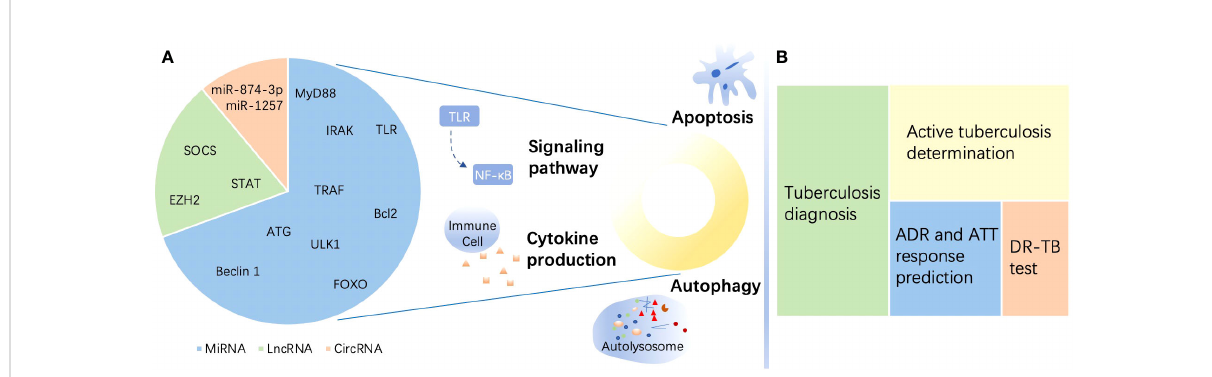
FIGURE 1 A brief summary of the roles of noncoding RNAs in tuberculosis. (A) Targets of noncoding RNAs (ncRNAs) in immune regulation in tuberculosis (TB) and estimated proportion of studies directed to the three ncRNAs enumerated in this review. MicroRNAs (miRNAs) mostly target myeloid differentiation factor 88 (MyD88), Toll-like receptor (TLR), tumor necrosis factor (TNF) receptor-associated factor (TRAF), and interleukin-1R- associated kinase (IRAK) to regulate signaling pathways and target Unc-51-like autophagy-activating kinase 1 (ULK1), autophagy-related gene (ATG), and beclin 1 to affect autophagy. Moreover, miRNAs target the Bcl-2 family and Forkhead box transcription factor class O (FOXO) to modulate apoptosis during TB. Long noncoding RNAs (lncRNAs) regulate the immune response in the host by targeting enhancer of zeste homolog (EZH) 2, suppressor of cytokine signaling (SOCS), signal transducer and activator of transcription (STAT), etc. Circular RNAs (circRNAs) perform immunity functions by acting as miRNA sponges. (B) ncRNAs serve as biomarkers in TB. ncRNAs show the potential to be biomarkers of different functions including diagnosis, active individual determination, adverse drug reaction (ADR) and response to antituberculosis therapy (ATT) monitoring, and drug resistance prediction of TB. DR-TB, drug-resistant